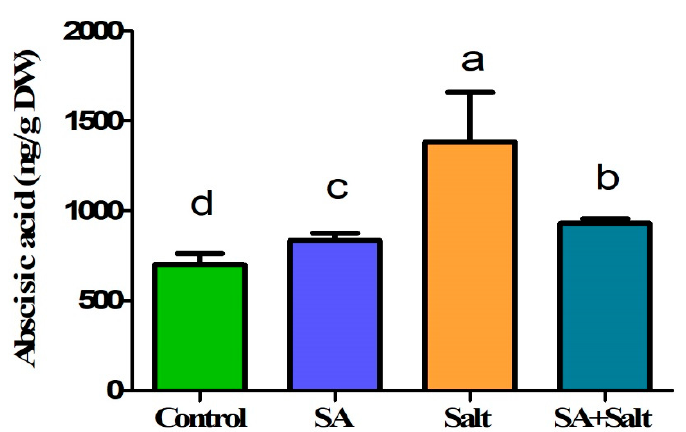
Figure 5. Effect of salicylic acid treatment on endo-ABA (abscisic acid) content of St. John’s wort under salt stress. Treatments: control, SA (0.25 mM salicylic acid), salt (150 mM NaCl), SA (0.25 mM salicylic acid) + salt (150 mM NaCl). Each value represents the mean ± SD ( n = 3). Different letters on each bar represent statistically significant differences as evaluated by DMRT and t -test at p ≤ 0.05.